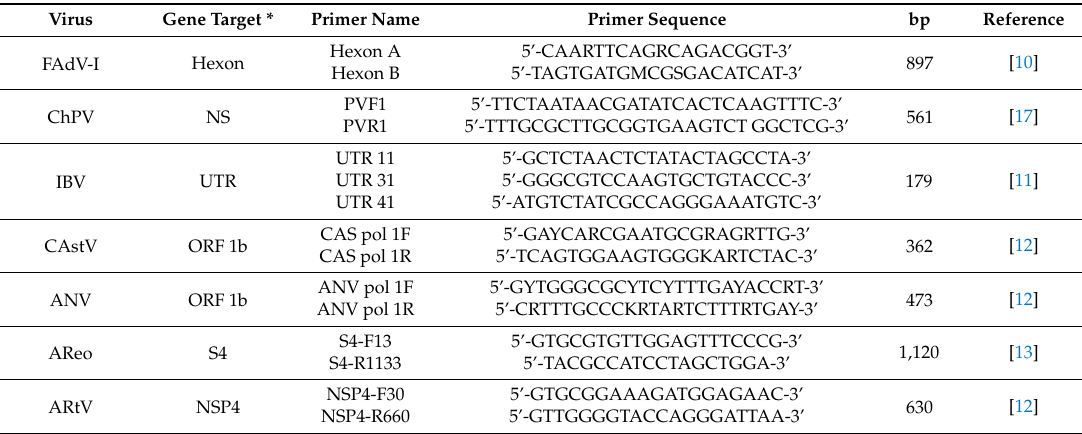
Table 1. Enteric viruses screened in this study with the name of the primers used in the RT-PCR and PCR reactions. Primer sequences and amplicon sizes are expressed in base pairs